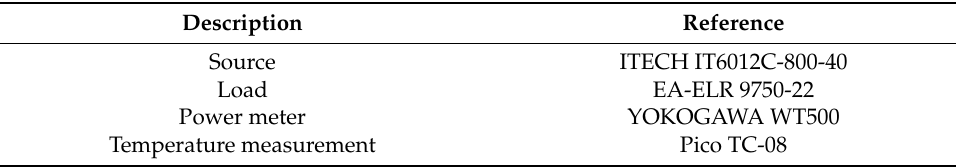
Table A1. Equipment used in the experimental tests.